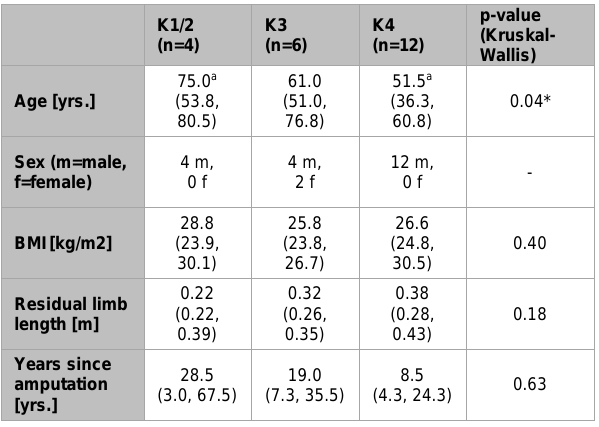
Table 1: Anthropometric and demographic data of the participants presented as median and IQR (25 th percentile, 75 th